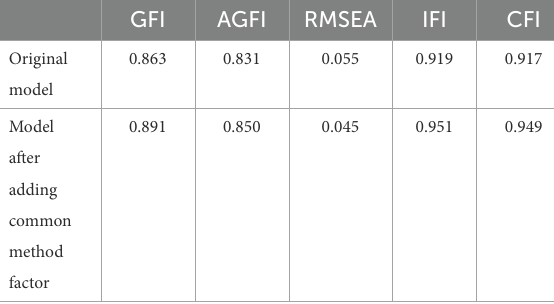
TABLE 6 Common method deviation test.